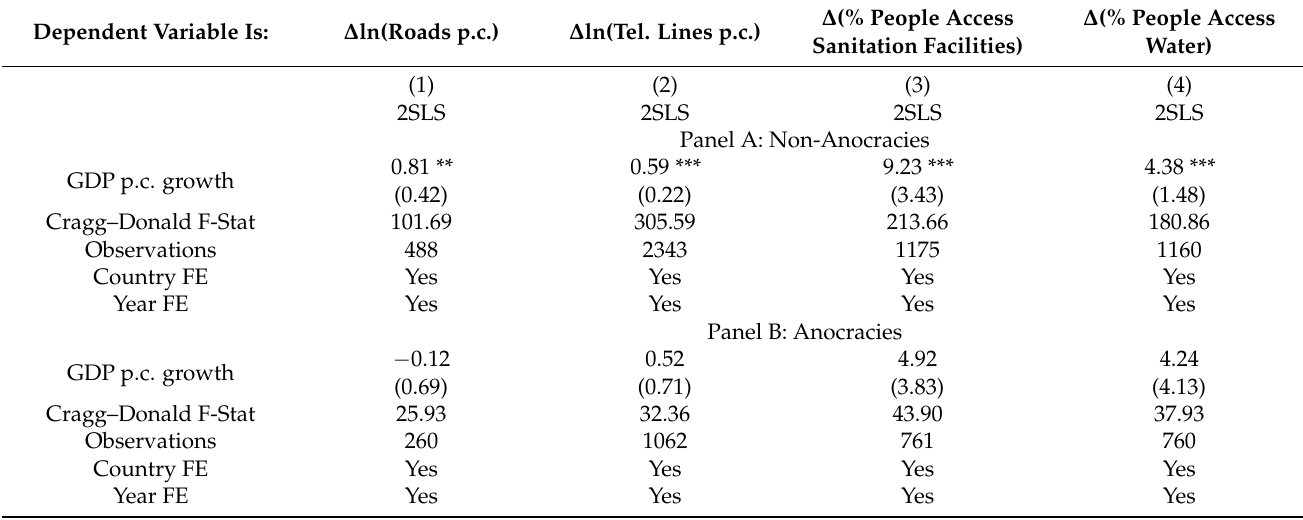
Table 9. GDP growth, anocracy, and infrastructure (sample